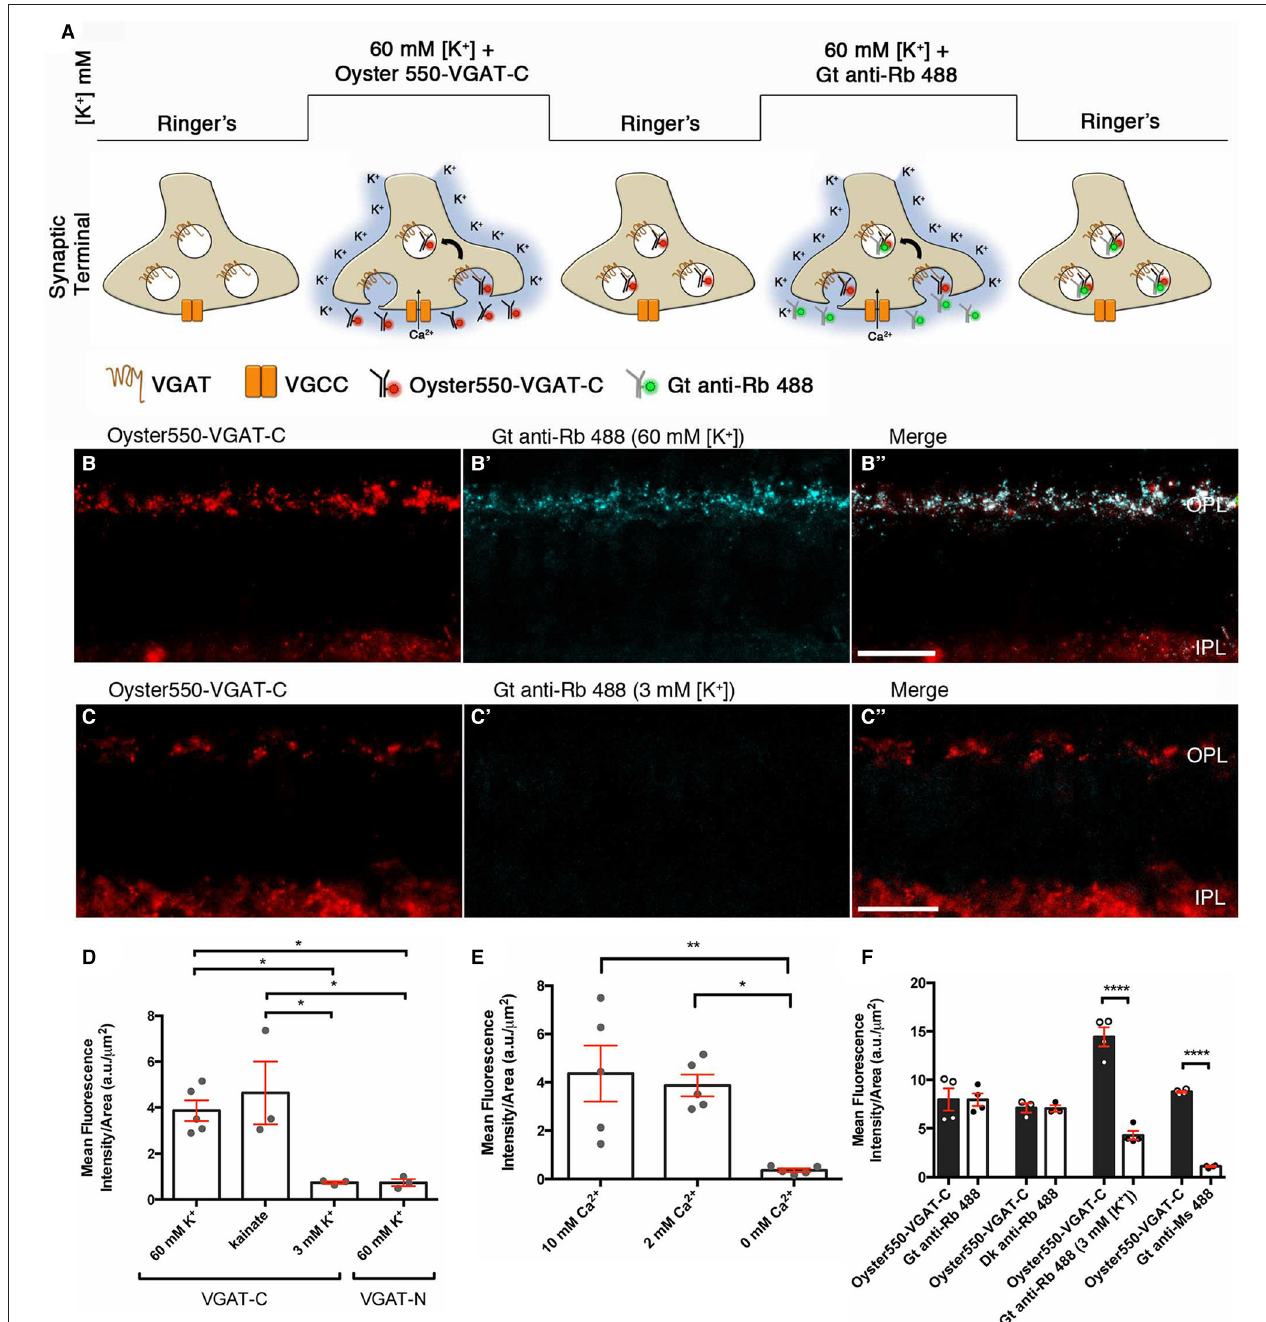
FIGURE 14 | A VGAT-C synaptic vesicle fusion assay demonstrated that vesicle fusion occurs in a depolarization- and calcium-dependent manner in horizontal cell endings. (A) Schematic depicts the luminal VGAT-C vesicle fusion assay protocol. Retinal slices are infused with extracellular medium containing VGAT-C antibodies, then depolarized with high [K + ] o that activates voltage-gated calcium channels and the subsequent Ca 2 + influx triggers synaptic vesicle fusion with the plasma membrane and, thus, exposure to the VGAT-C antibodies in the extracellular space. (B,C) panels showed the Oyster550-VGAT-C immunolabeling (red) of the fused vesicles. (B’) panels showed that a second round of depolarization and vesicle fusion labeled by Alexa488-conjugated secondary antibodies (blue) in the extracellular medium that recognizes the VGAT-C rabbit polyclonal antibodies from the first round of labeling, indicating that the synaptic vesicles recycle, as seen in the merged images ( B” , white). (C’-C”,D) Control experiments showed that there was little to no vesicle fusion when slices were maintained in the basal 3mM [K + ] o . (D) Quantification of VGAT-C immunofluorescence was significantly increased when depolarized with high (60mM) [K + ] o or 50 µ M kainate, but not with basal 3mM [K + ] o . When VGAT-N antibodies that recognize a cytosolic epitope not exposed to extracellular milieu were used, no specific labeling of horizontal cell endings was